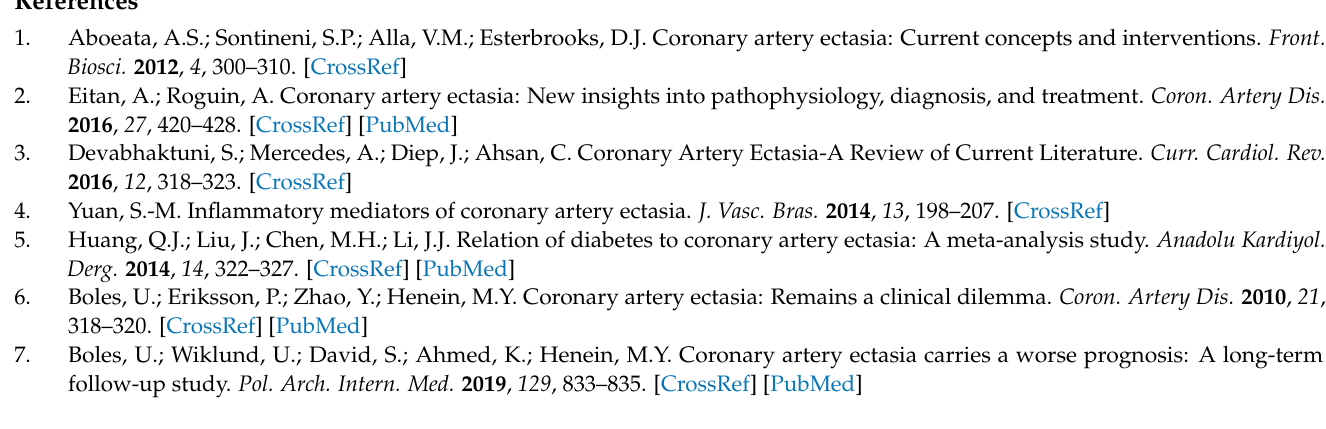
CAE versus CAD, Figure S3: Funnel plot for hs-CRP CAE versus Controls (Egger test; p = 0.071), Figure S4: Funnel plot for hs-CRP CAE versus CAD (Egger test; p = 0.169), Figure S5: Funnel plot for IL-6 CAE versus Controls, Figure S6: Funnel plot for IL-6 CAE versus CAD, Figure S7: Funnel plot for TNF-a CAE versus Controls, Figure S8: Funnel plot for TNF-a CAE versus CAD, Figure S9: Funnel plot for RDW CAE versus Controls, Figure S10: Funnel plot for RDW CAE versus